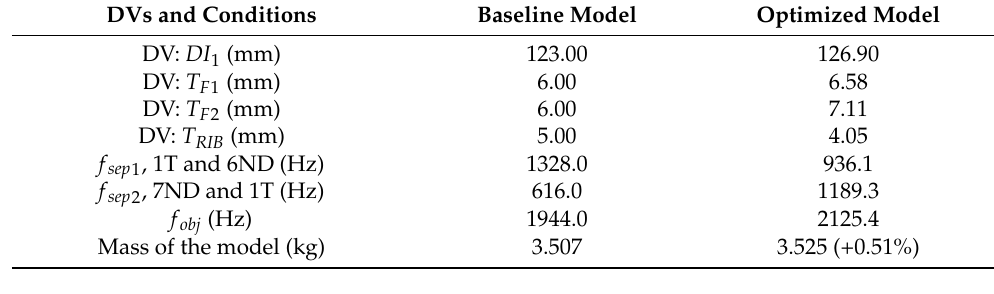
Table 4. Optimization results for Case 1.